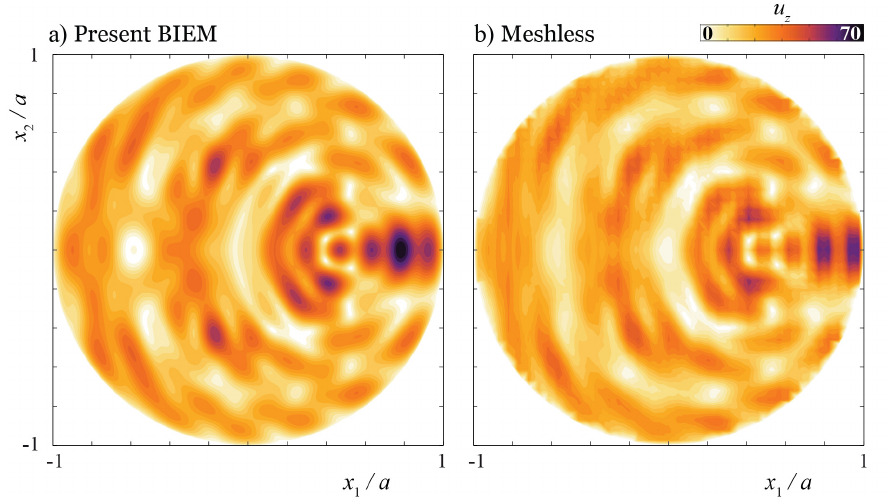
Figure 5. Amplitudes of the vertical components of the COD |(cid:52) u 3 ( x 1 , x 2 ) | of a circular open crack calculated using the present BIEM and the meshless approach [39] for the transverse wave incident at 30 ◦ angle to plane x 3 = 0 and 90 ◦ ayngle to plane x 2 = 0: space made of glass, k T 2 a = 20.